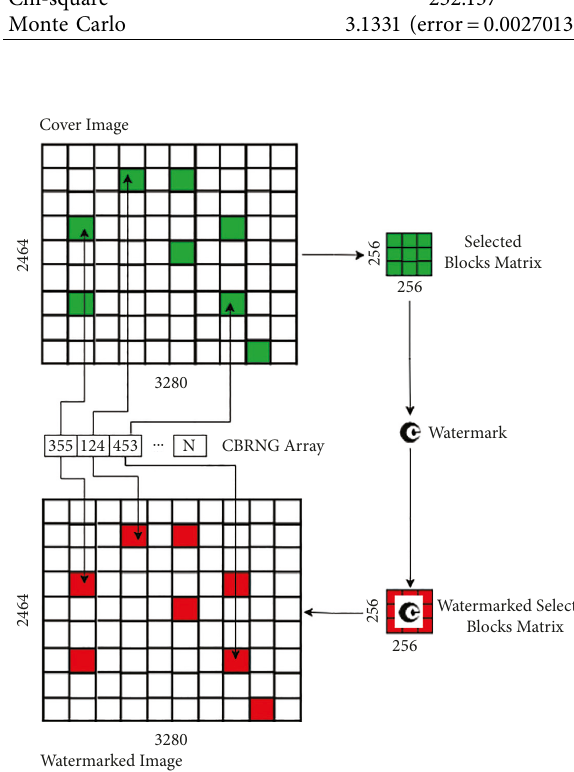
Figure 7: Working principle of the proposed chaos-based RNG watermarking